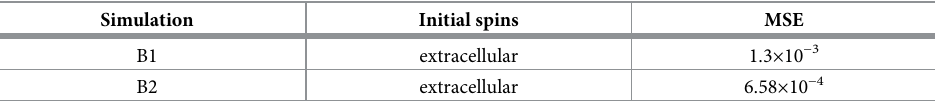
Table 4. The MSE between the FA values obtained with quadratic and linear gradients for the numerical fibre